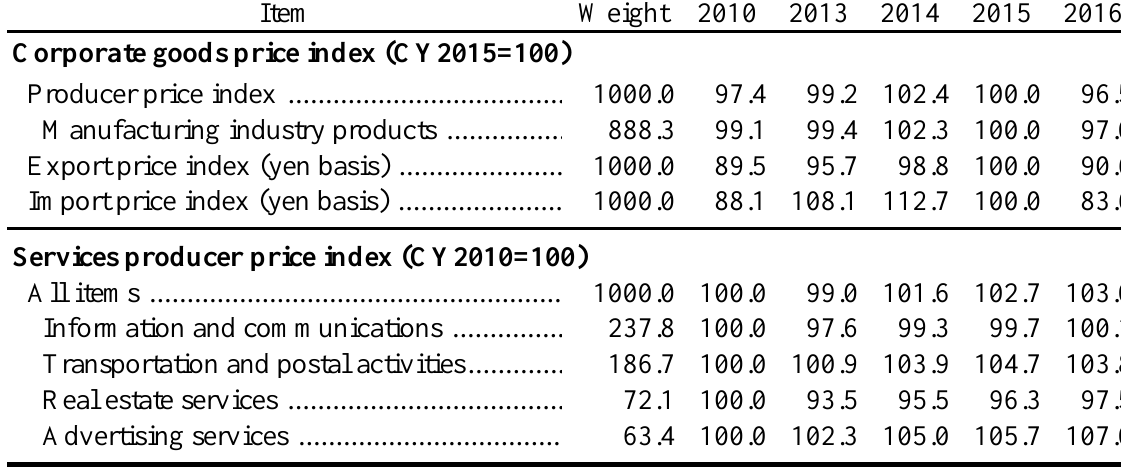
Corporate Goods and Services Producer Price